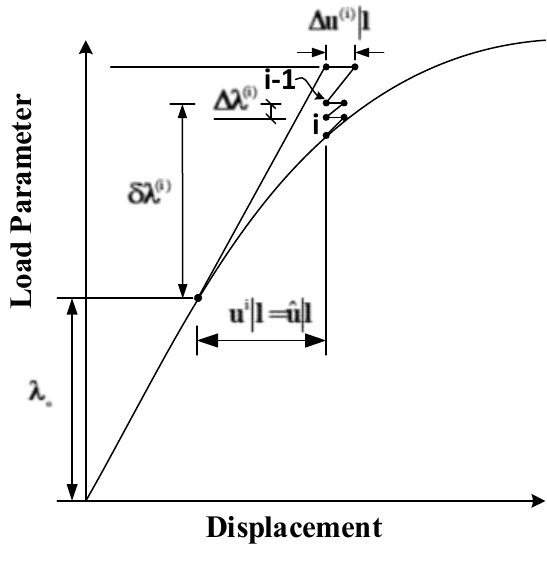
Fig. 3 Displacement control method (Batoz and Dhatt